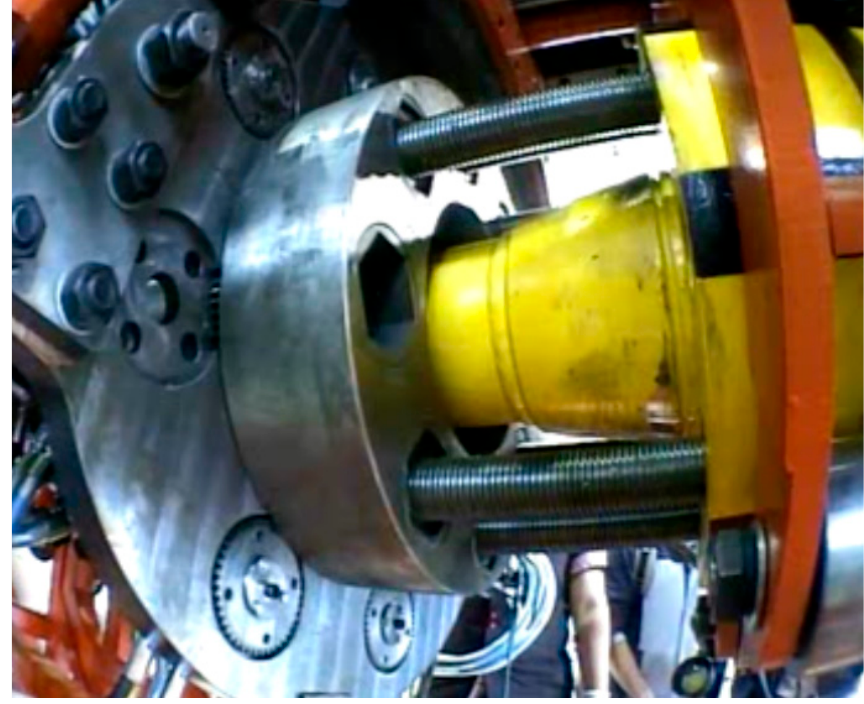
Figure 16. The land test.